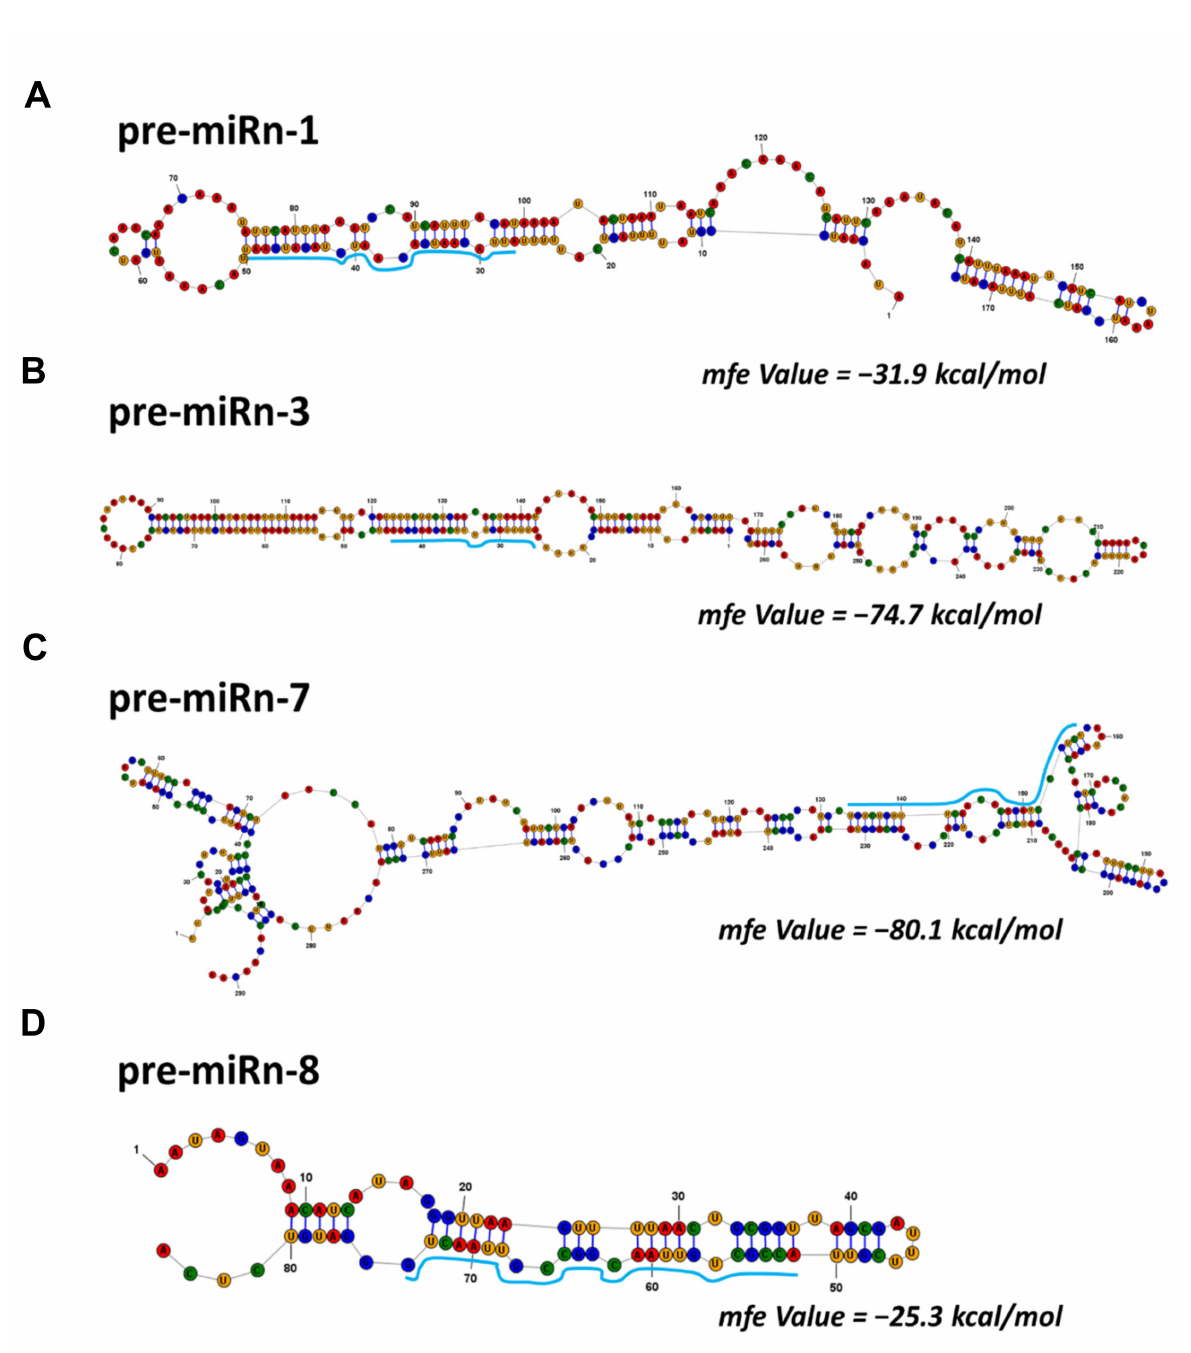
Figure 3. Secondary structures for the novel miRNA precursors. Predicted hairpin secondary structures for the potential novel miRNA precursors of (A) miRn-1 ( B ) miRn-3, ( C ) miRn-7, and ( D ) miRn-8. Nucleotide bases of mature miRNA are highlighted in light blue. The actual size of each putative precursor might differ slightly from its shown length since it was not identified experimentally. The computed minimum free energy (MFE) of the thermodynamic ensemble is reported. RNAstructure version 6.2 software was employed to evaluate the stem-loop structure with default parameter